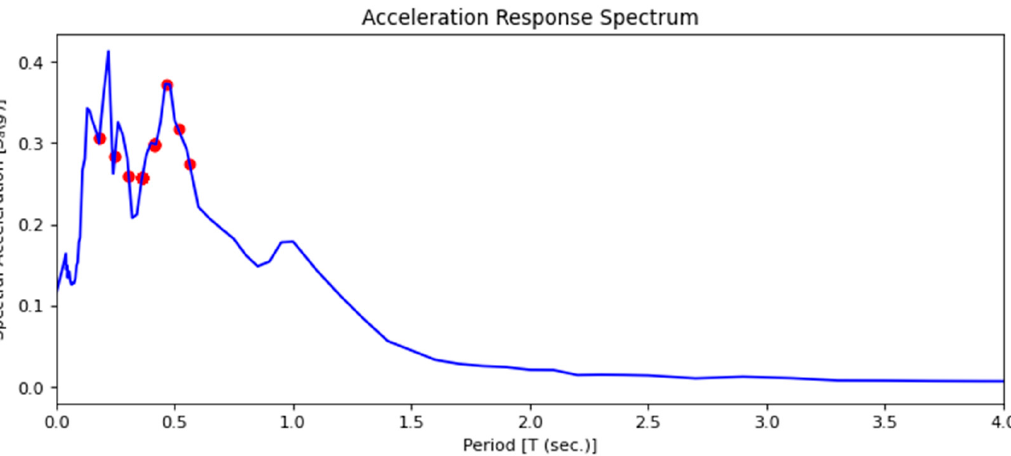
Figure 4. Spectral acceleration values for the considered buildings based on building height.